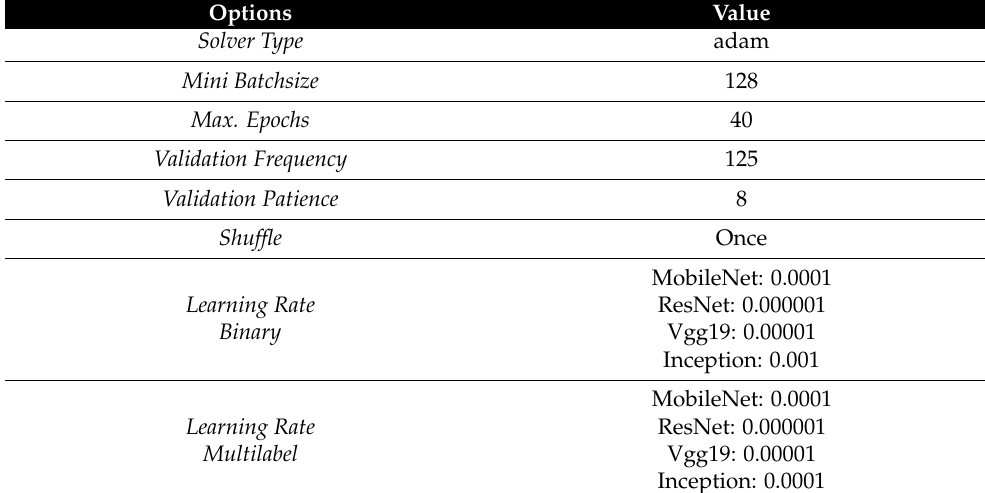
Table 3. Training parameters for the CNN models.